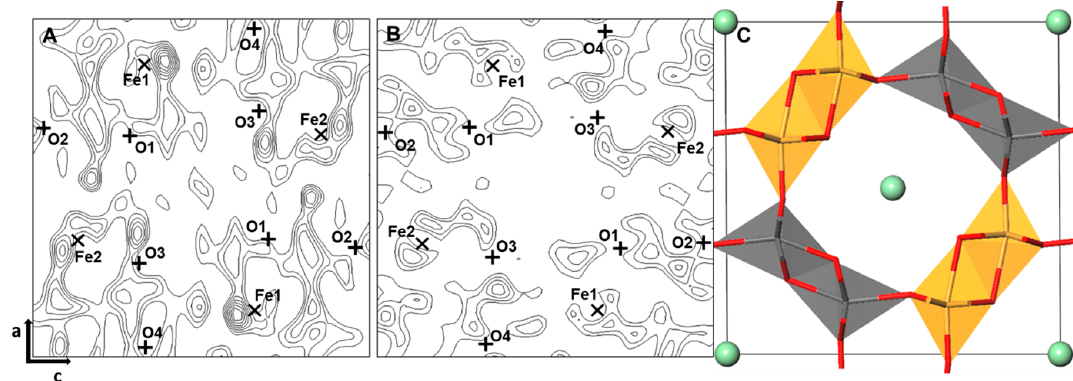
Figure 1. ( A ) Calculated initial stage difference electron Fourier (DELF) map of the X ‐ ray powder diffraction data using only the akaganéite octahedral framework at y = 0. For clarity, only the negative contours are plotted. The contour interval is 0.3 scattering units. ( B ) DELF map after refining to the case (2) under the same conditions as ( A ). ( C ) The tunnel structure obtained by refinement and applied for base model DFT-D calculations. The green ball represents Cl, Ge and the framework is composed of (Ge,Fe)OOH octahedra.